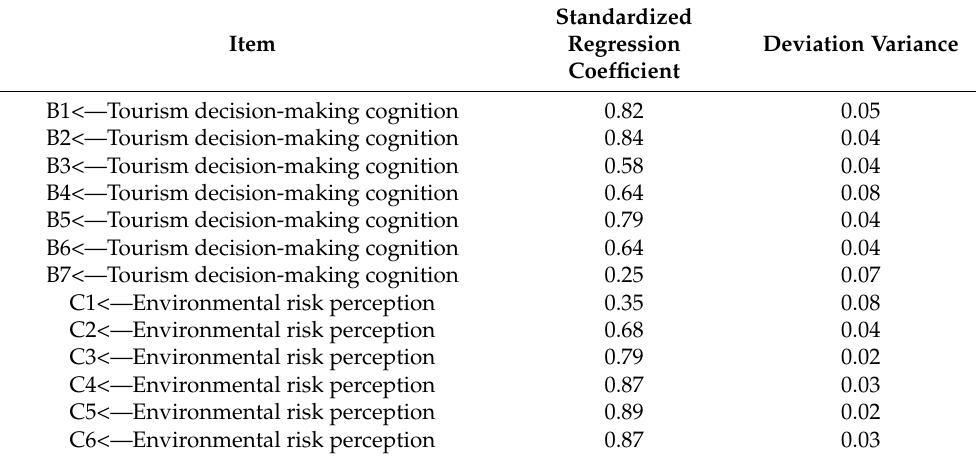
Table 3. Offending estimates of the scales for tourism decision-making cognition, travel environ- mental risk perception, epidemic prevention attitude, physical and mental health assessment, and travel